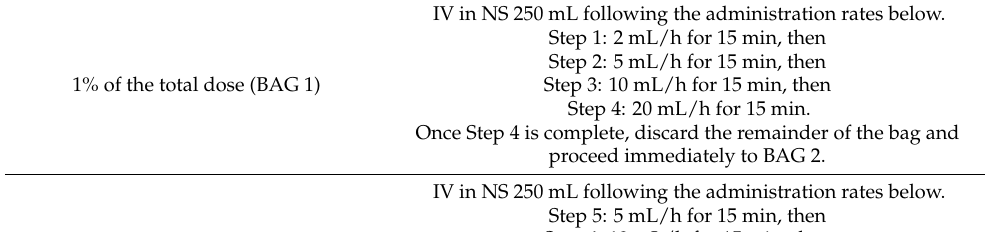
Table 1. Trastuzumab Desensitization Protocol